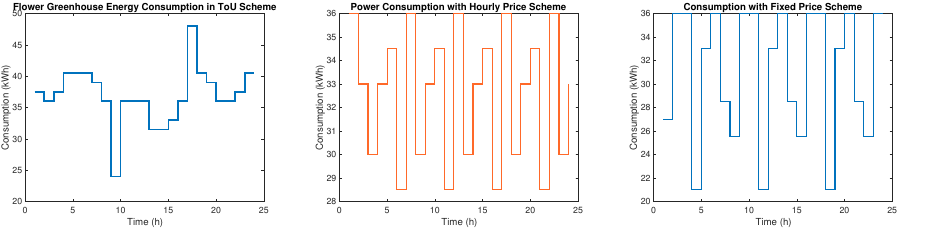
Figure 8. Flower Greenhouse Energy Consumption in Response to Pricing Schemes. Table 2. Pricing Schemes